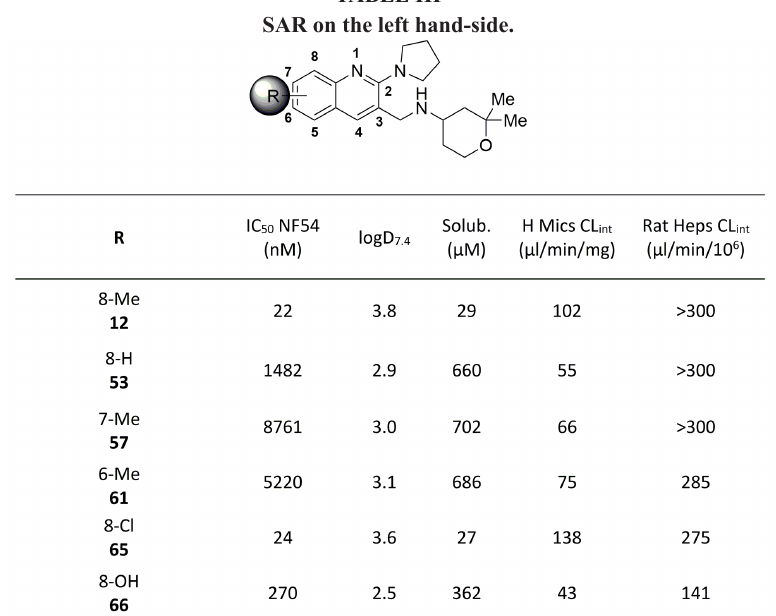
SAR on the left